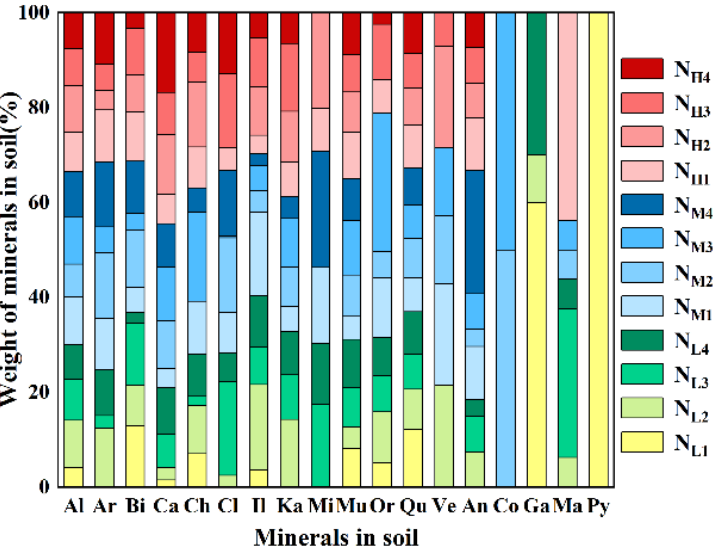
Figure 9. Phase analysis of representative soil sample. N L1 to N L4 are lower than RSV of Pb samples, N M1 to N M4 are between RSV and RCV of Pb samples, and N H1 to N H4 are higher than RCV of Pb